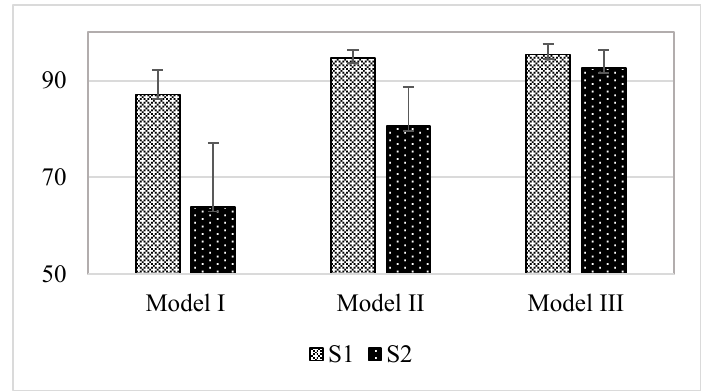
Figure 7. Performance comparison of Model I, Model II, and Model III.